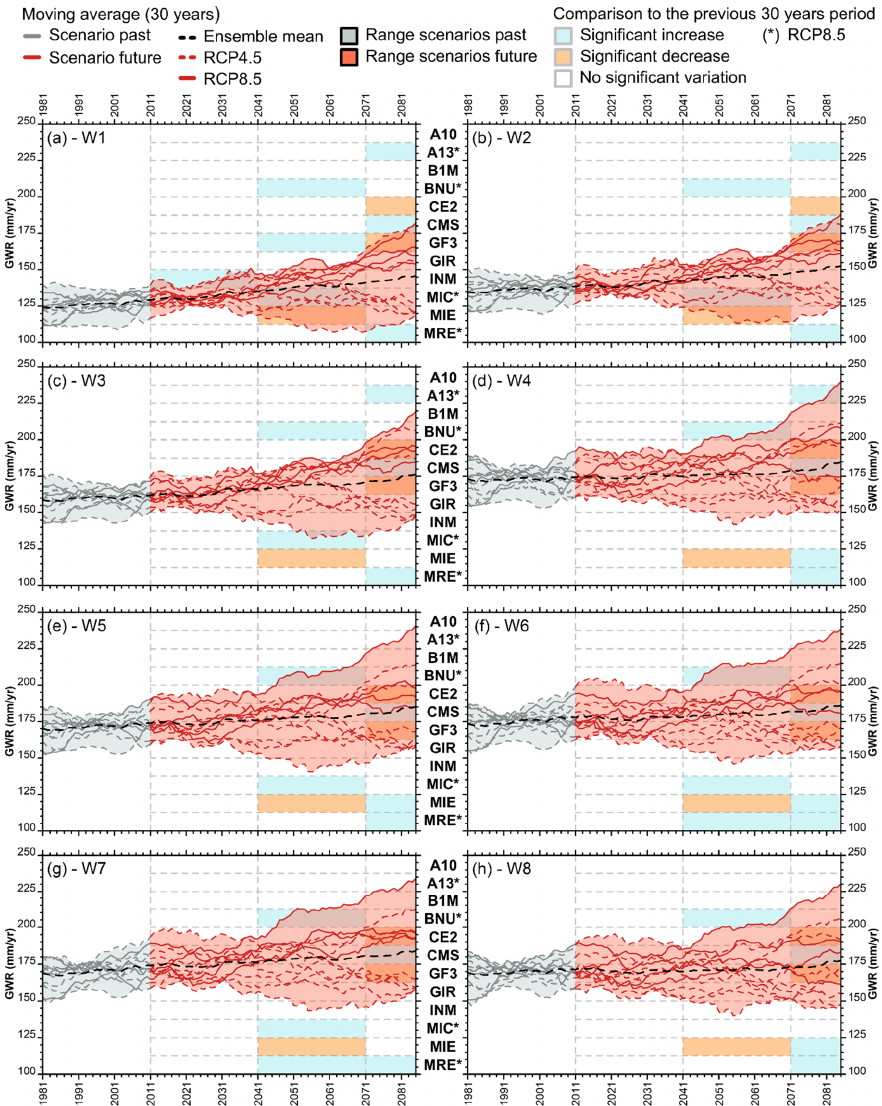
Figure 4. Thirty-year moving average of groundwater recharge (GWR) simulated with the 12 climate scenarios and significant changes (Tukey test, p < 0.05) between subsequent 30-year periods (2011– 2040, 2041–2070, and 2071–2100) for ( a ) W1 to ( h )